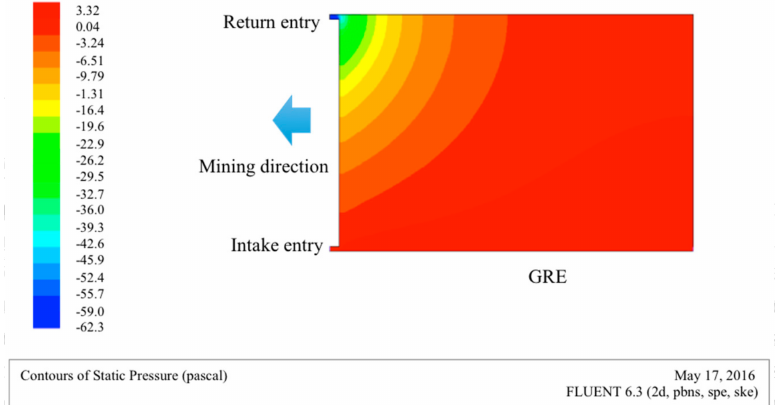
Figure 3. Contour of air pressure in the gob of